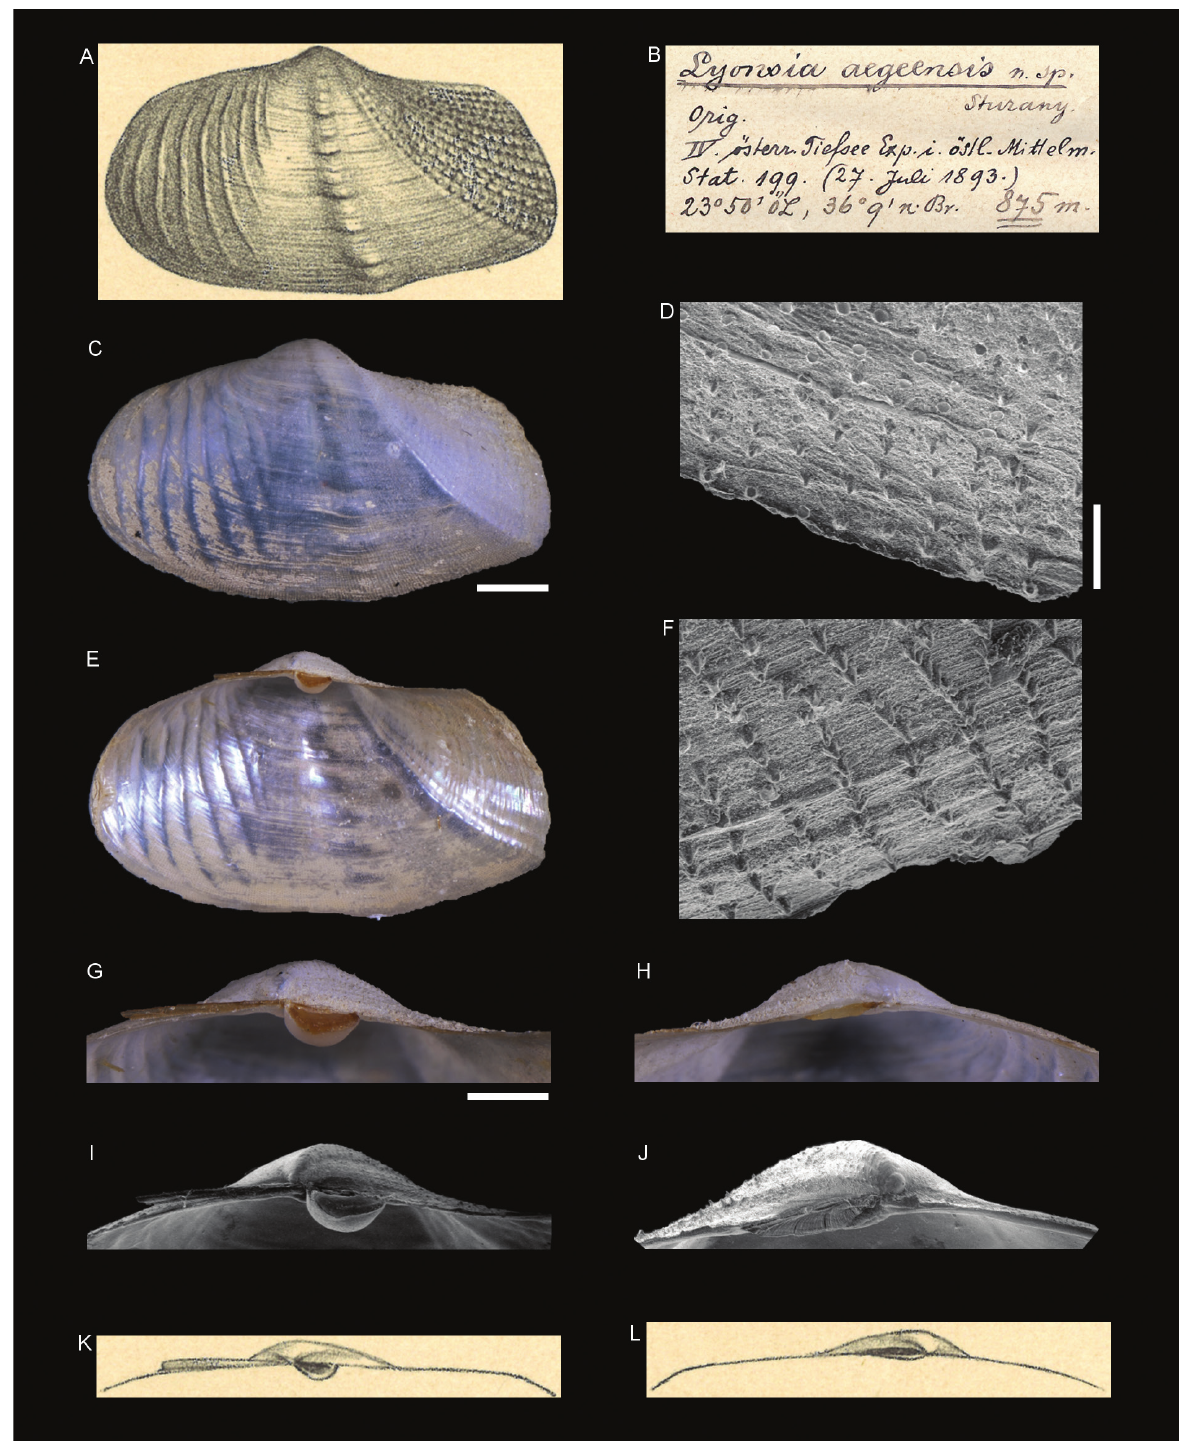
Figure 14. Lyonsia aegeensis Sturany, 1896, Station 199, southwest of Kythira, Sea of Crete, Greece, 875 m. A , K , L . Original figures in Sturany, 1896. B . Original label. C–J . Syntype NHMW 13004: outer view of left valve ( C ), inner view of right valve ( E ), microsculpture ( D , F ), hinge right valve ( G , I ) and left valve ( H , J ). Scale bar: 2 mm ( C, E ), 0.2 mm ( D, F ), 1 mm ( G–J